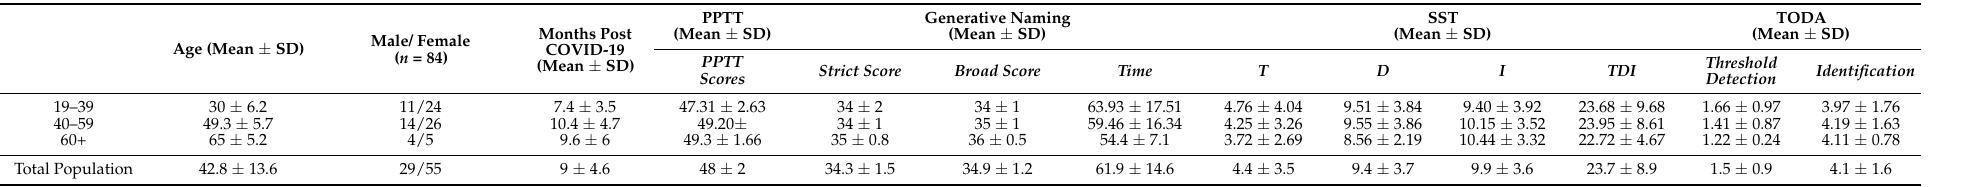
Table 2. Subtests scores. SD: standard deviation. SST = Sniffin’ Sticks Test; T = SST threshold subtest; D = SST discrimination subtest; I = SST identification